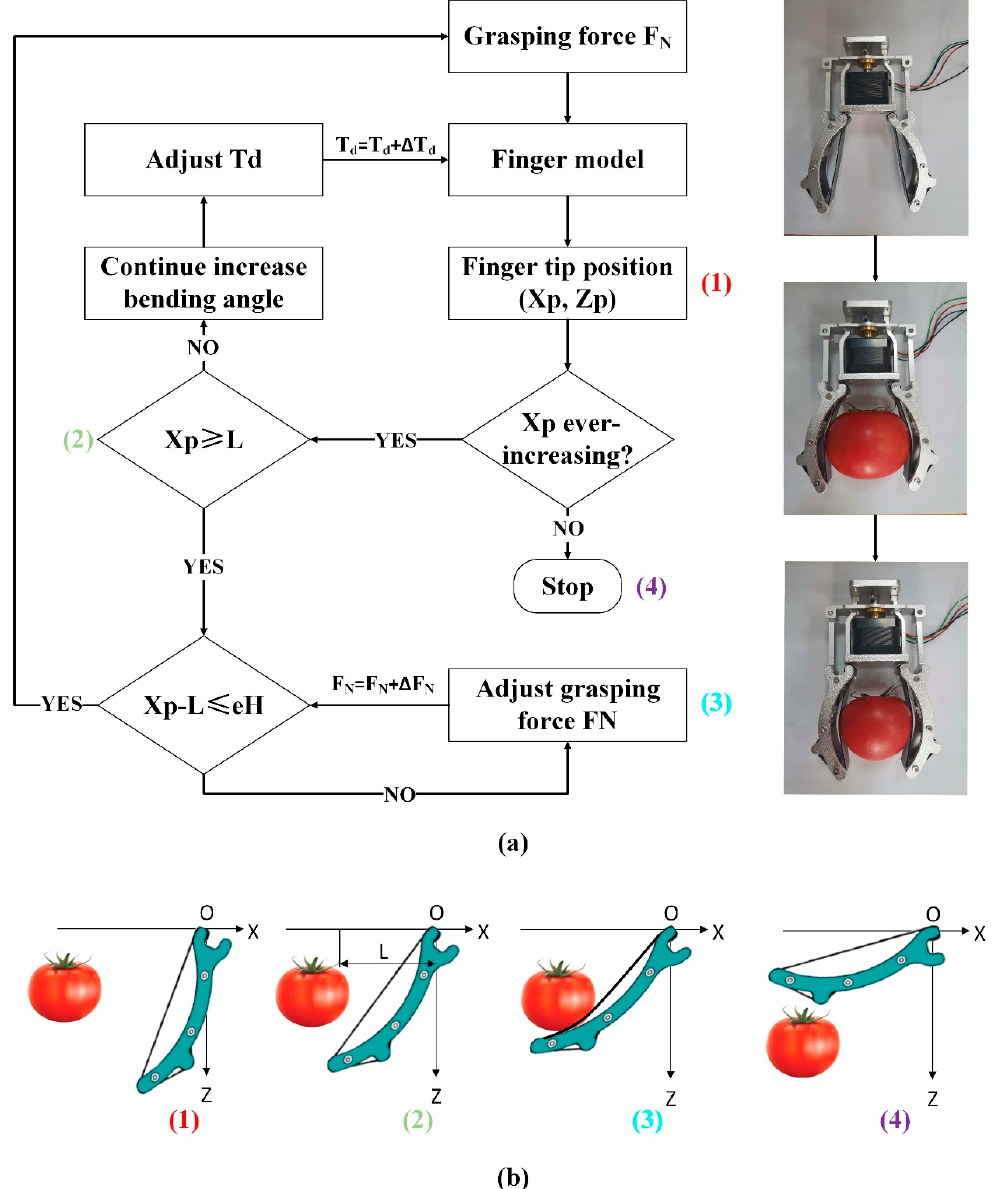
Figure 3. Manipulator grasping control chart. ( a ) Flow chart of calculation methodology of grasping force (the places marked with numbers correspond to the positions in ( b )). ( b ) Schematic diagram of finger deflection process.